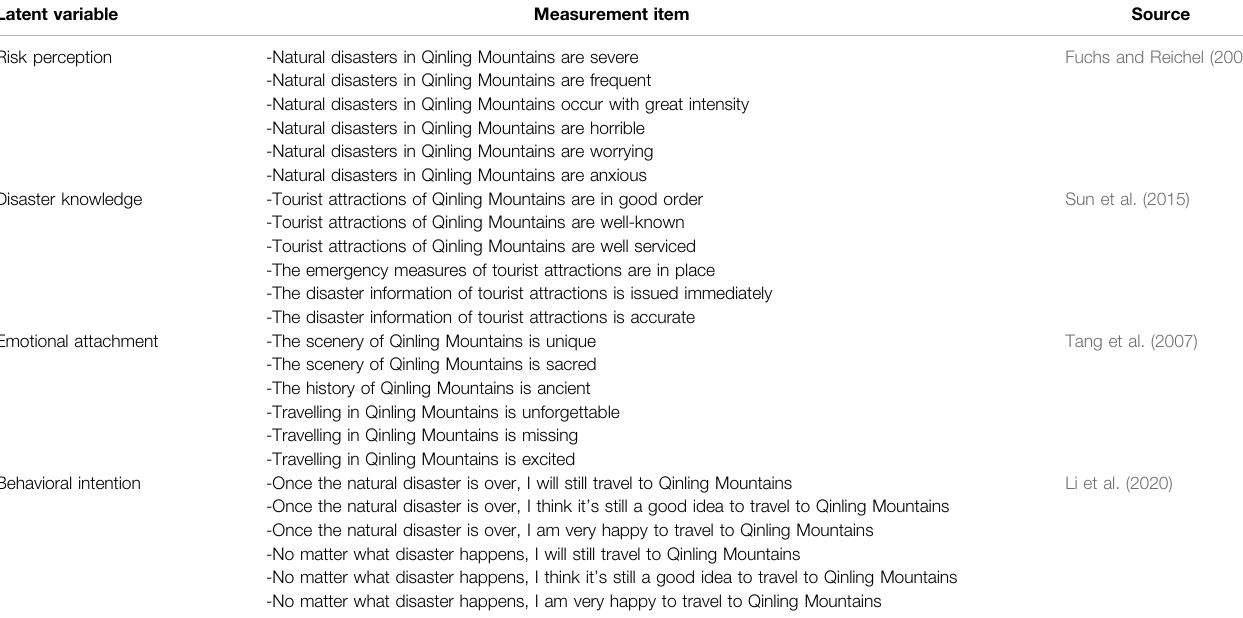
TABLE 1 | Latent variables and measurement items used in the conceptual